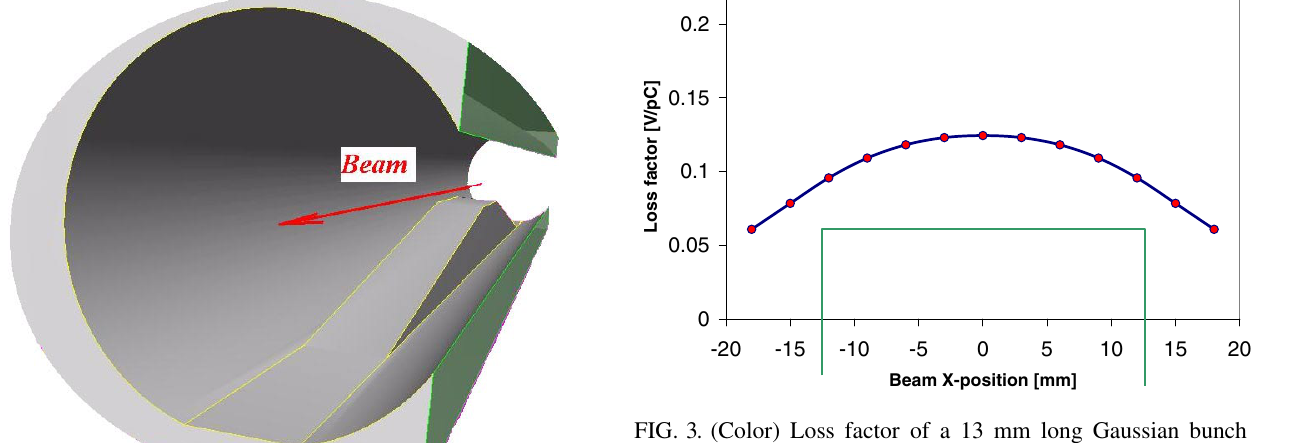
FIG. 3. (Color) Loss factor of a 13 mm long Gaussian bunch passing the vertical collimator at different offsets in the vertical position. The green line shows the collimator edge. Loss factor of a 13 mm long Gaussian bunch passing the vertical collimator at different offsets in the horizontal position. The green line shows the collimator edge.